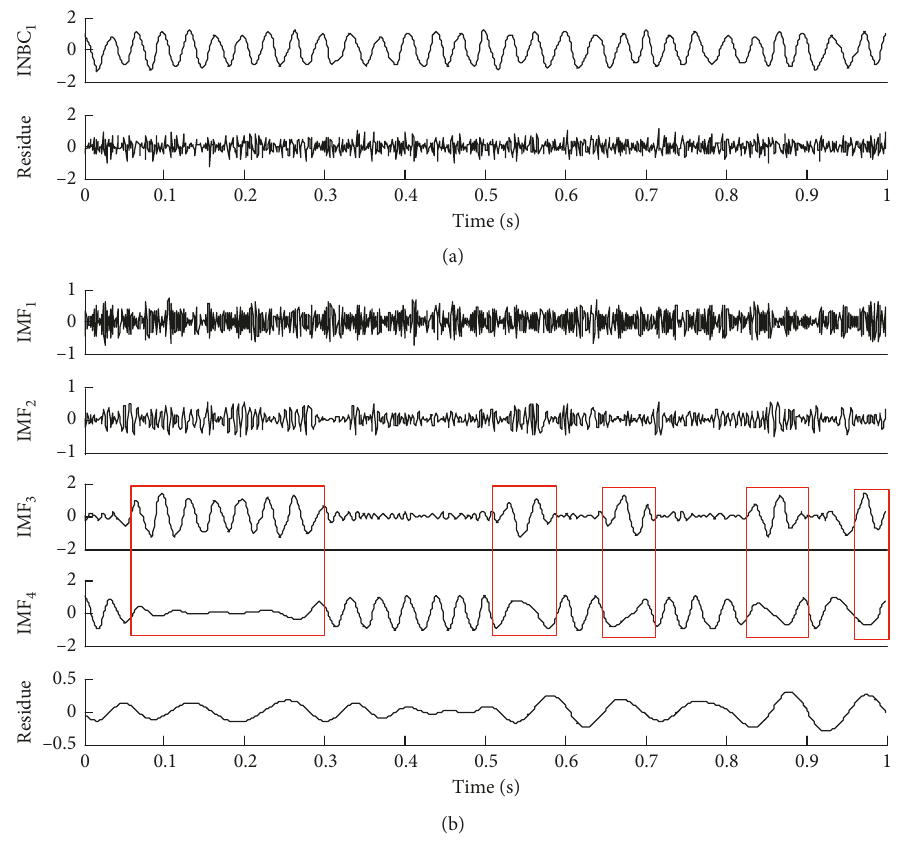
Figure 7: The decomposition results generated by ASNBD and EMD of simulation signal x decomposition results of (a) ASNBD; (b)